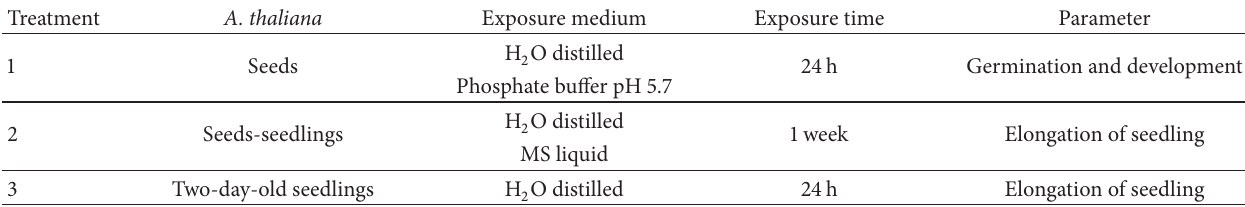
Table 1: Treatments of exposition of A. thaliana to